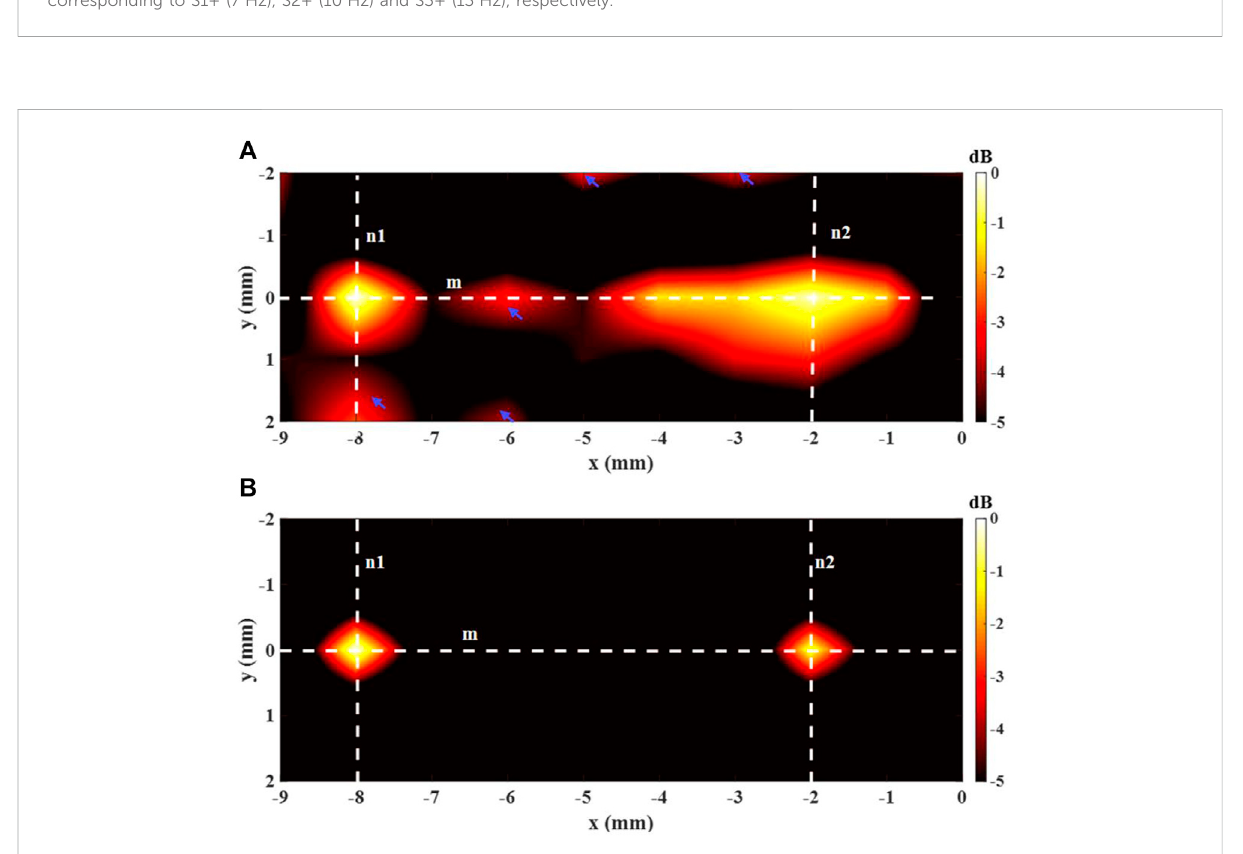
FIGURE 6 Imaging result of the 2-source with (A) DAE and (B) aDAF (hot colors, 5-dB dynamic range).